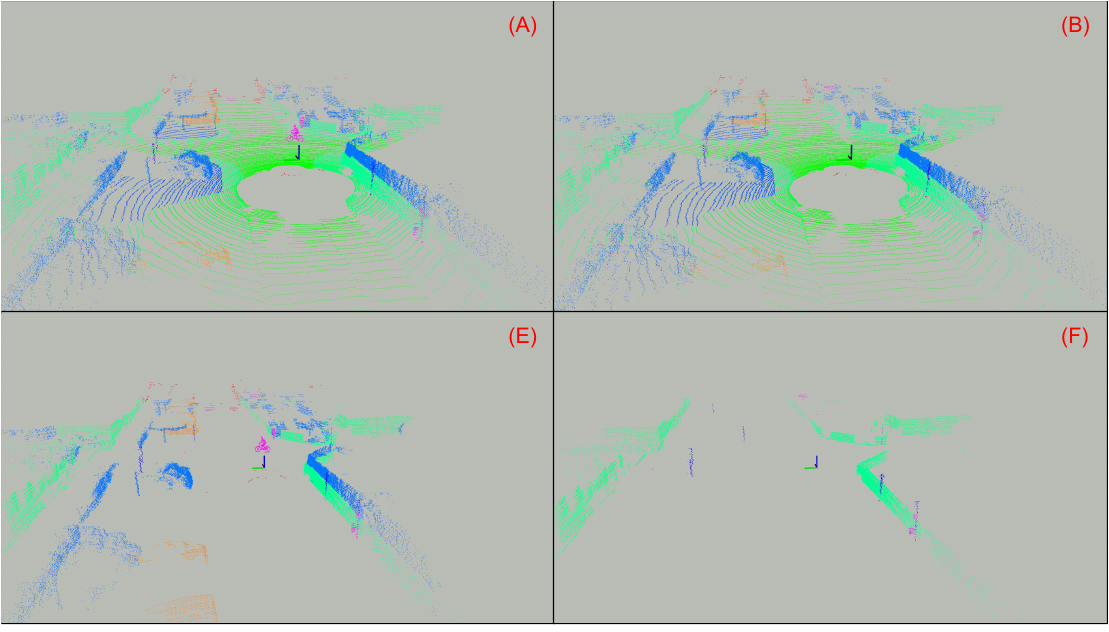
Figure 1. Samples of point clouds resulting from some of the tested configurations. Letters ( A , B , E , F ) refer to different configurations, described in Section